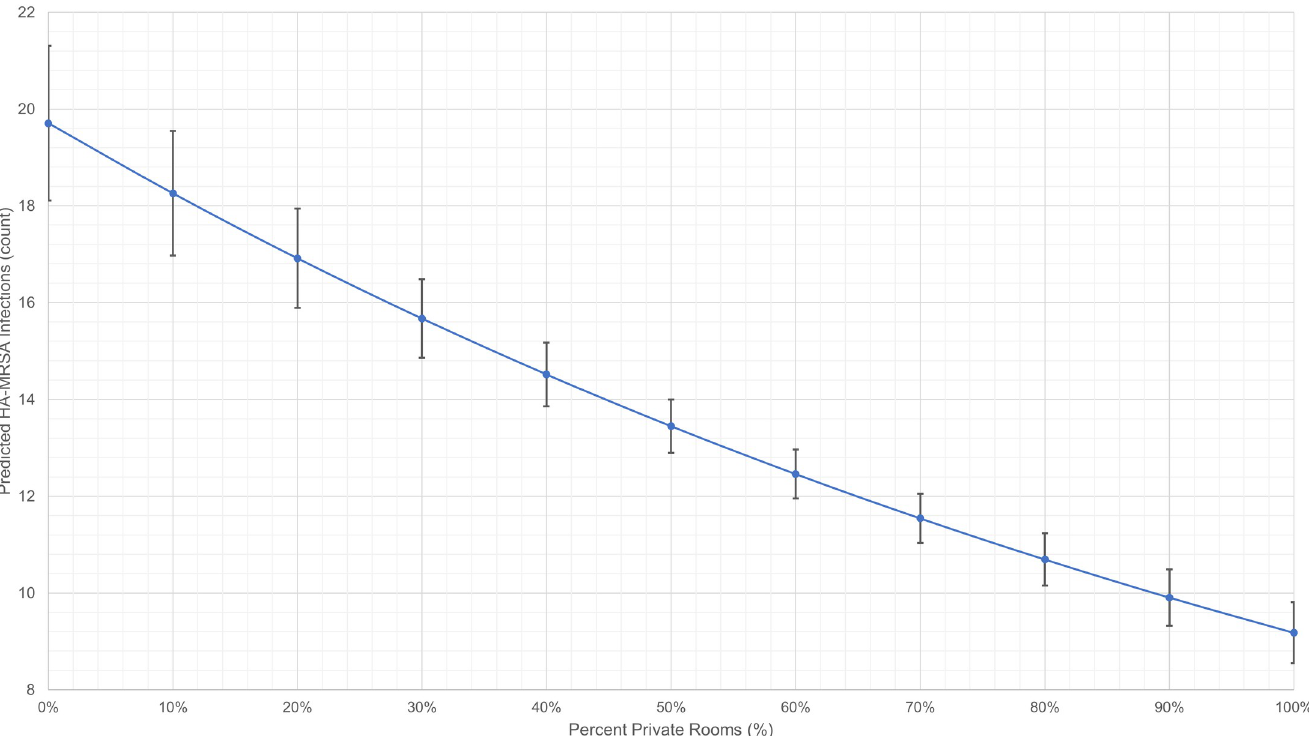
Fig 1. Association between the proportion of PPRs and predicted rates of HA-MRSA. HA-MRSA, hospital-acquired methicillin-resistant Staphylococcus aureus infection. PPRs, private patient rooms. Illustration of the average marginal effects of PPRs on HA-MRSA infection rates, which were estimated using a multivariable negative binomial regression model. Data included discharges between September 2015 and August 2016 from 340 US hospitals.